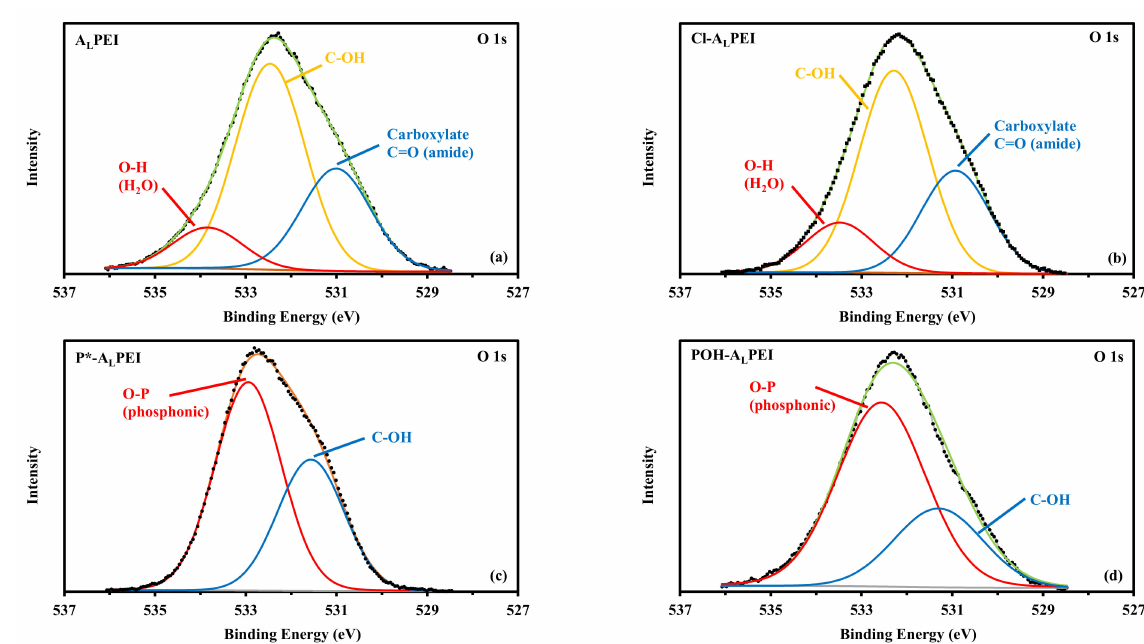
Figure 5. HRES XPS O 1 s core level spectra for A L PEI ( a ), Cl-A L PEI ( b ), P*-A L PEI ( c ) and POH-A L PEI ( d ).